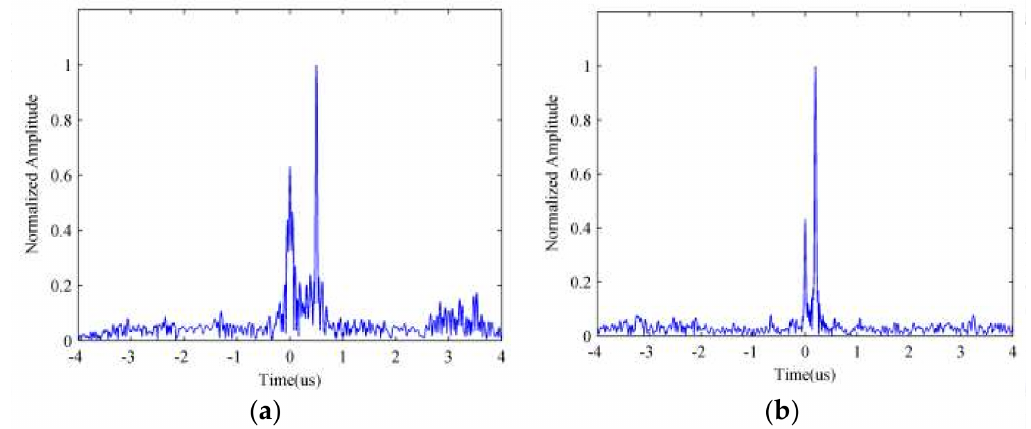
Figure 5. The pulse compression result of the radar echo signal containing ISRJ with different parameters transmitting random